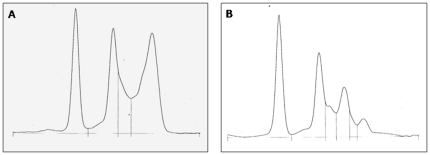
Protein electrophoretic pattern.A) Protein electrophoretic profile showing a typical gammapathy found in kestrel individuals infected by Chlamydophila abortus (Chlamydophila psittaci serovar I). B) Normal kestrel protein electrophoretic profile.